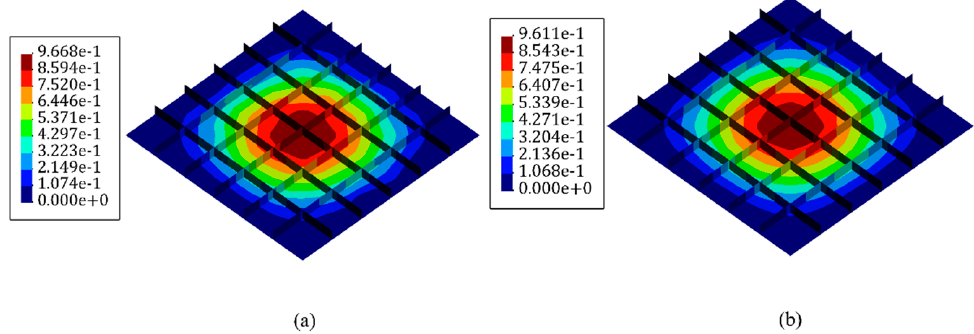
Figure 26. The transverse displacement contour of the stiffened plate with ( a ) iFEM-GA analysis and ( b ) the reference model.